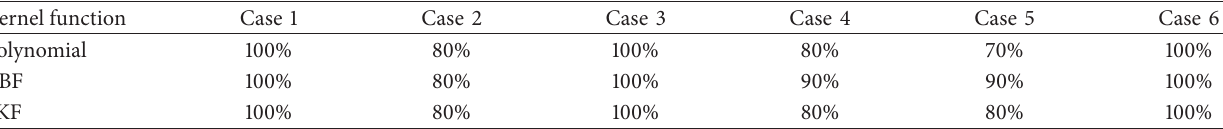
Table 7: The accuracy of damage pattern classification with different kernel function.